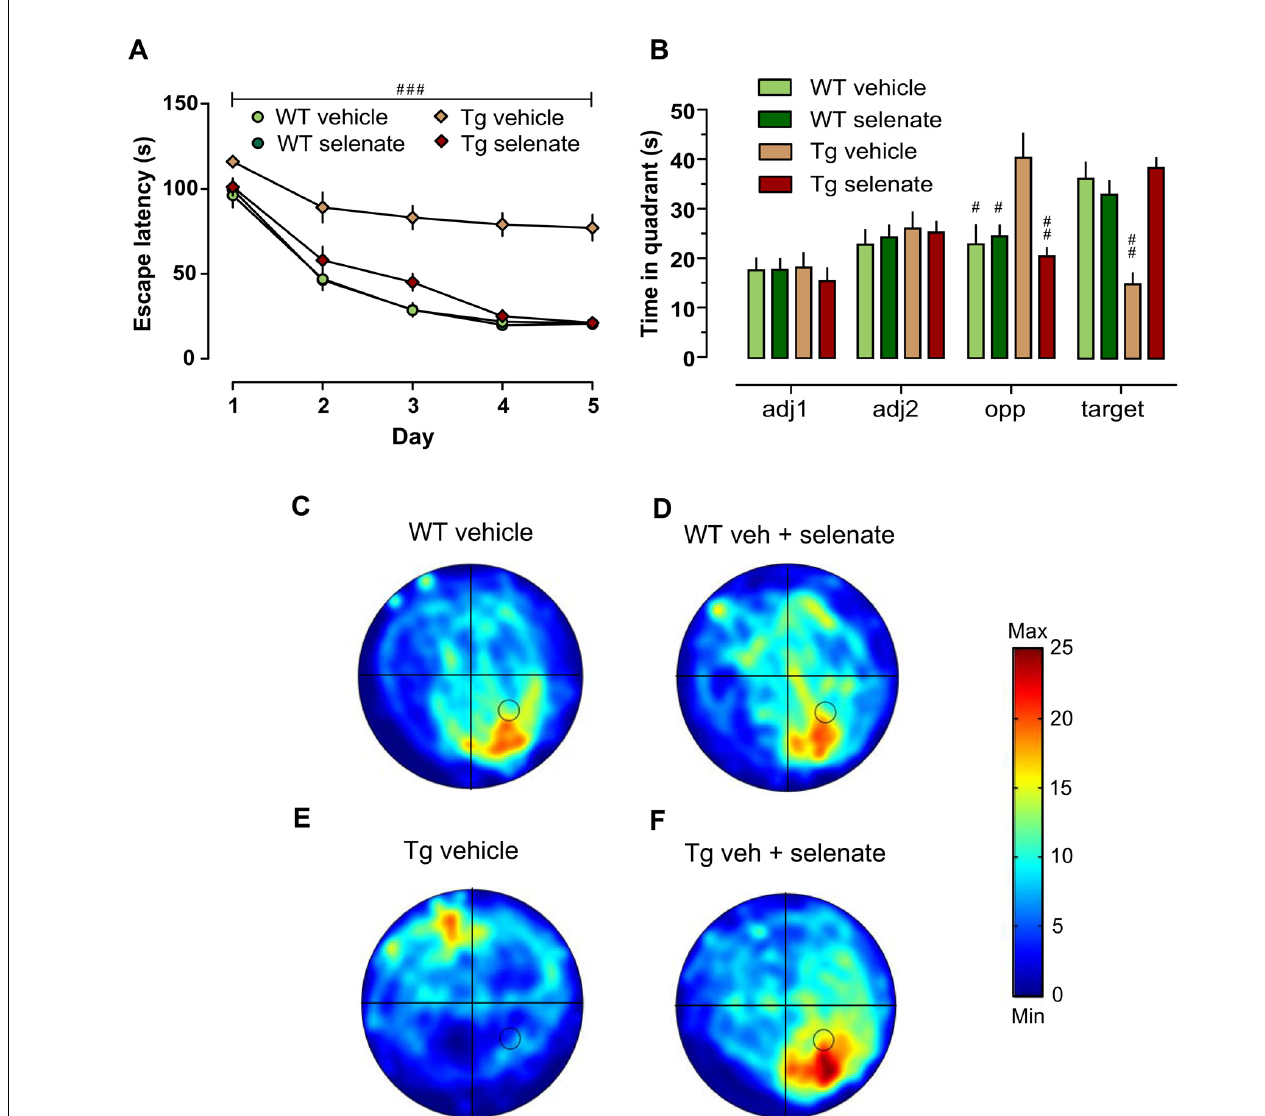
FIGURE 2 | Impaired spatial learning and memory of Tg mice in the Morris water maze (MWM) was restored by treatment with selenate. (A) Tg mice provided with dietary selenate displayed escape latencies for locating the hidden platform comparable with the selenate-treated WT and non-treated WT groups. In contrast, the vehicle-treated Tg group were poor learners. (B) In the probe test, both WT groups and selenate-treated Tg groups confirmed memory for the platform location by spending significantly more time in the platform quadrant compared to vehicle-treated Tg mice. The vehicle-treated Tg group, in contrast, spent significantly less time in the target quadrant and showed a preference for the opposite quadrant instead (adj = adjacent 1/2, opp = opposite and target; hashes denote statistically significant differences between vehicle-treated Tg mice and the other three groups). (C–F) Examples of heat maps of the swim patterns during probe tests. The location of the platform is marked in the heat map as a black circle in the bottom right quadrant. (C) WT vehicle, (D) WT selenate-treated, (E) Tg vehicle, (F) Tg selenate-treated. Note the clear target preference of Tg after selenate treatment in panel (F) as compared to vehicle-treated Tg in (E) . The heat map scale bar indicates the time in seconds. Mean ± SEM is given; group sizes: Tg-veh n = 9, Tg-sel n = 10, WT-veh n = 8, WT-sel n = 9. Bar with ### indicates significance level p ≤ 0.001 of RM-ANOVA with a Dunnett post hoc test using Tg vehicle as comparison; # and ## represent p ≤ 0.01 and p ≤ 0.001, respectively, in the Dunnett post hoc